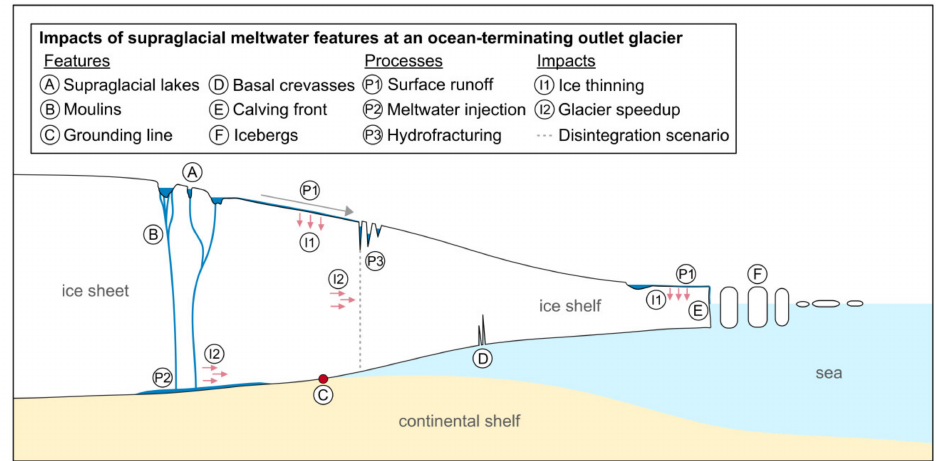
Figure 1. Supraglacial meltwater accumulation at an ocean-terminating outlet glacier with ice shelf in Antarctica. The three main processes (P1–P3) a ff ecting ice dynamics and mass balance through supraglacial lake formation are illustrated schematically: (P1) Surface melting and runo ff leading to ice thinning (I1). (P2) Meltwater injection to the glacier bed causing transient ice flow accelerations (I2). (P3) Meltwater-induced ice shelf collapse causing ice flow accelerations